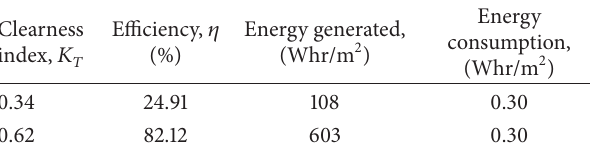
Table 1: The efficiency ( 𝜂 ), energy gained by the DAST over SSS, and energy consumption under different clearness index.